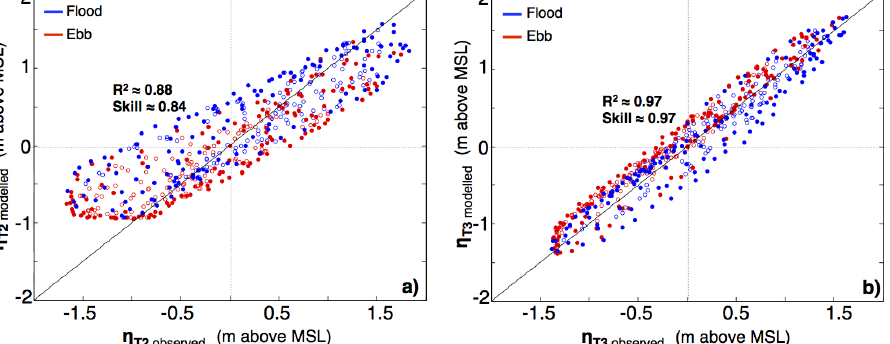
Figure 5. Observed vs modelled tidal water levels, for stations T2 ( a ) and T3 ( b ). Both water level data used for calibration (empty dots) and testing (solid circles) are shown, for the two different phases (red symbols refer to the ebb phase, blue symbols correspond to the flood